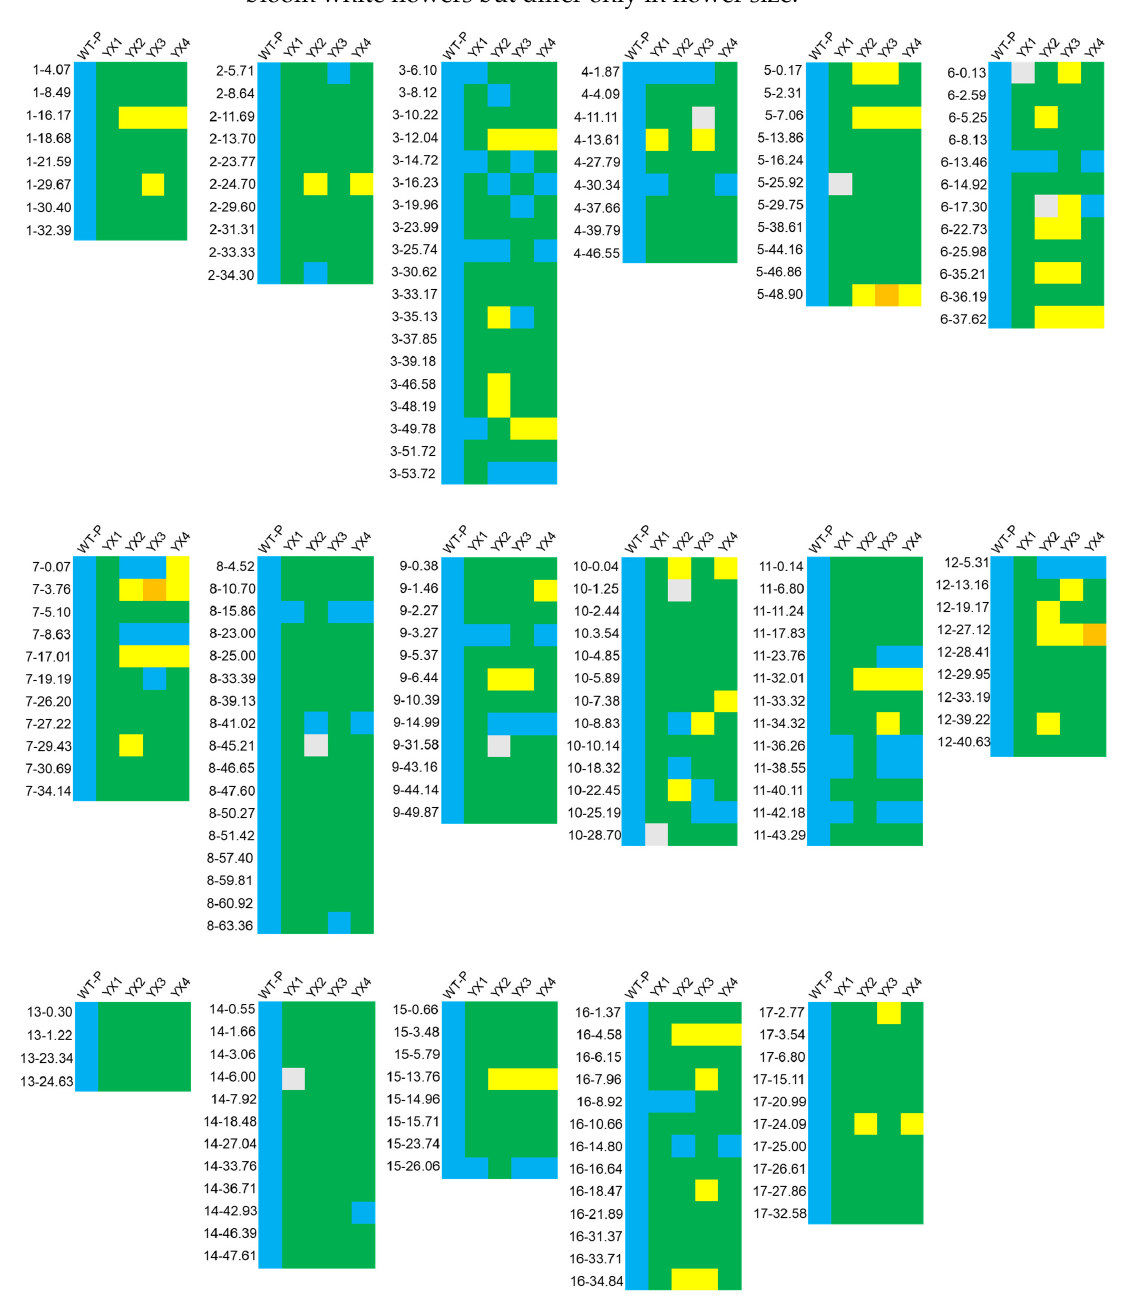
Figure 4. Matrix of the polymorphisms using the InDel markers among the five accessions of G. paniculata . Blue squares are WT-P bands, green, yellow and orange squares represent bands different from WT-P, and grey squares mean no bands detected.